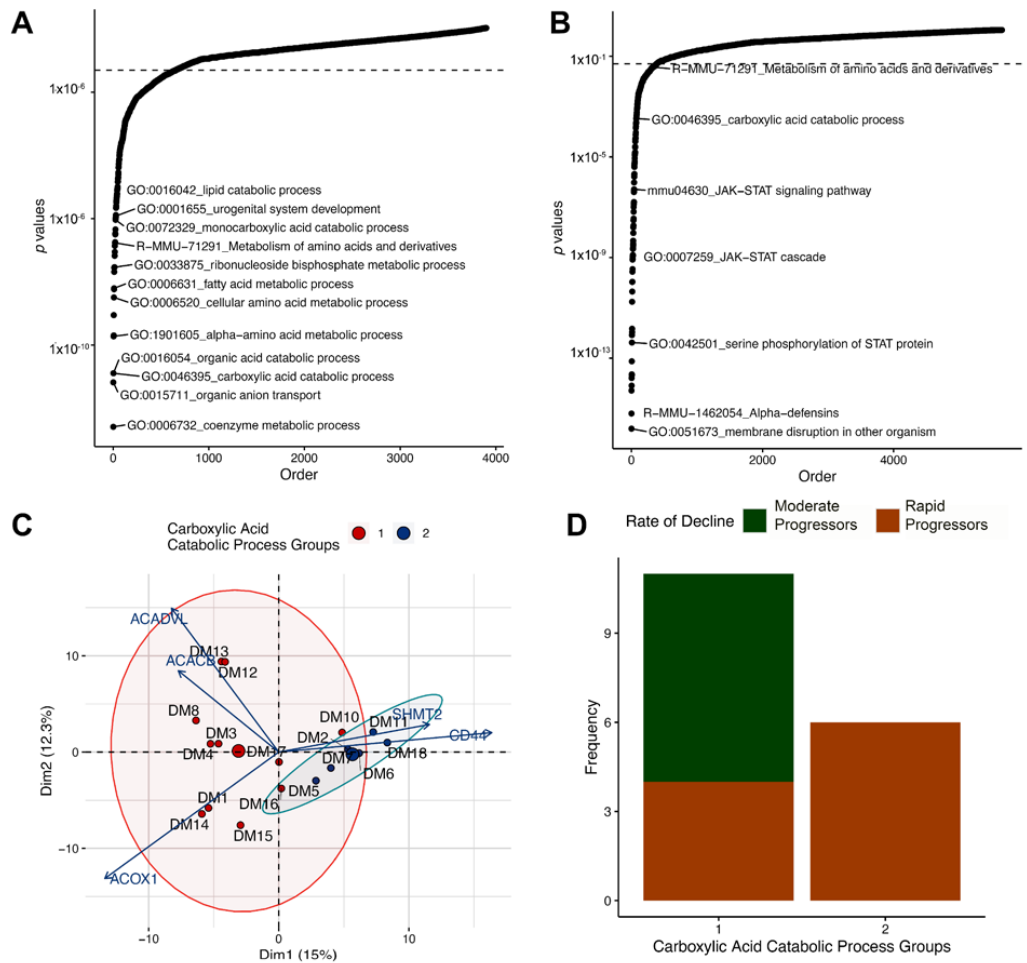
Figure 5. Carboxylic acid catabolic process gene expression associated with increased progression of diabetes. Pathway analysis between diabetic and controls in the proximal tubules of ( A ) mice and ( B ) humans. X-axis: Pathways ordered by p -values. Y-axis: − Log 10 of p -values. ( C ) Principal component analysis of human diabetic proximal tubule samples clustered with carboxylic acid catabolic process genes using partitioning around medoids. Arrows represent the degree of impact and direction